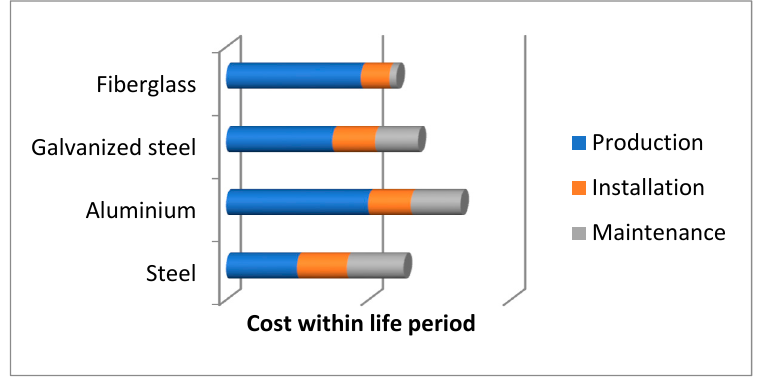
Figure 1. Materials’ comparison [36] .